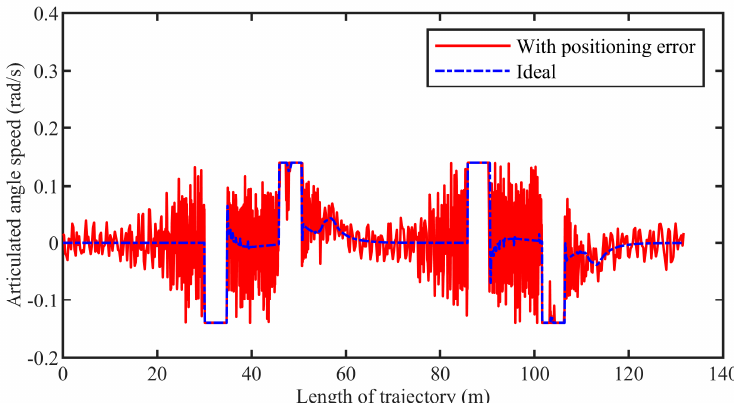
Figure 20. The articulated angle of the simulation with positioning errors.